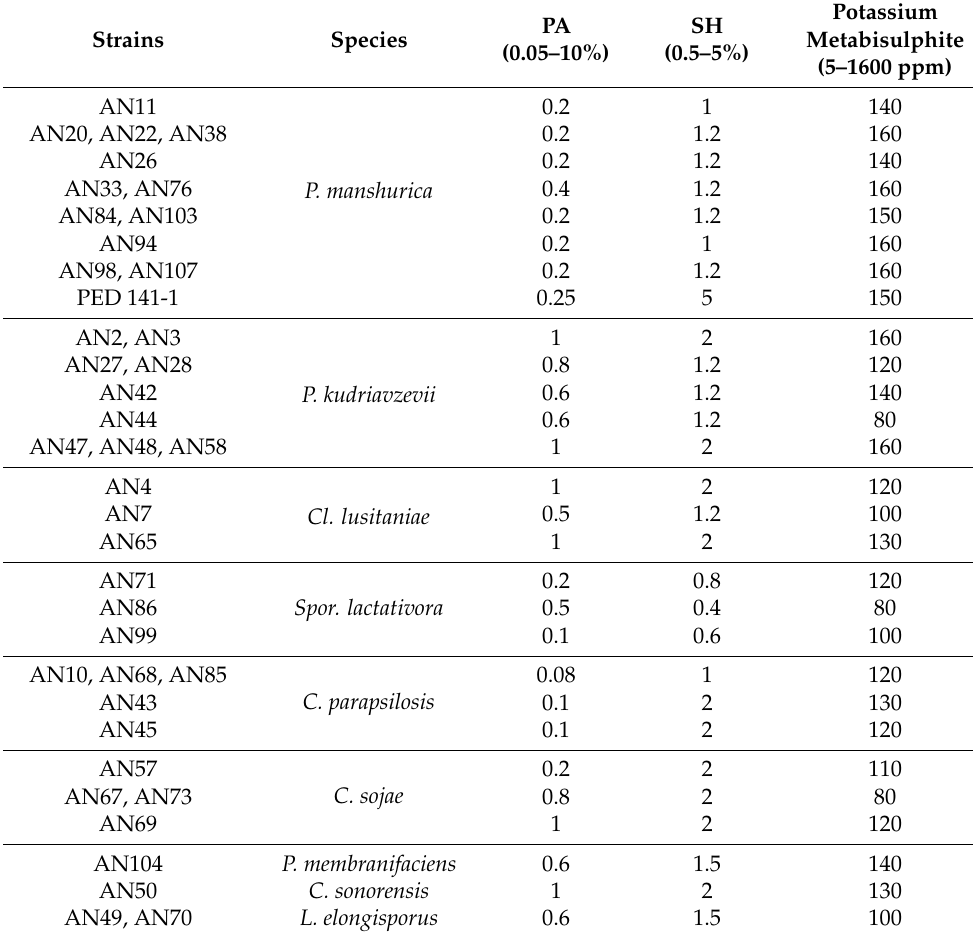
Table 1. Minimum inhibitory concentrations (MICs) of cleaning agents and potassium